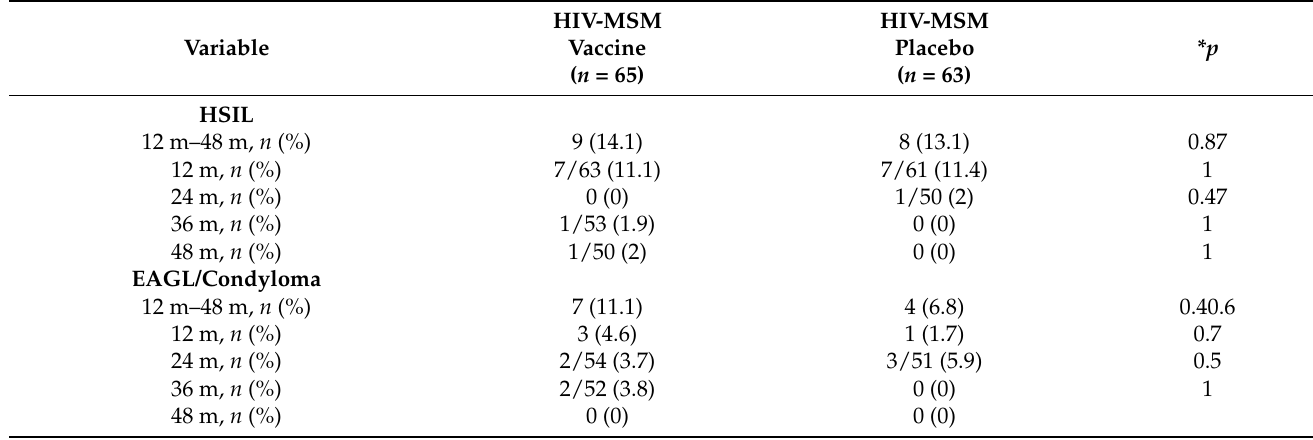
Table 3. Efficacy of qHPV